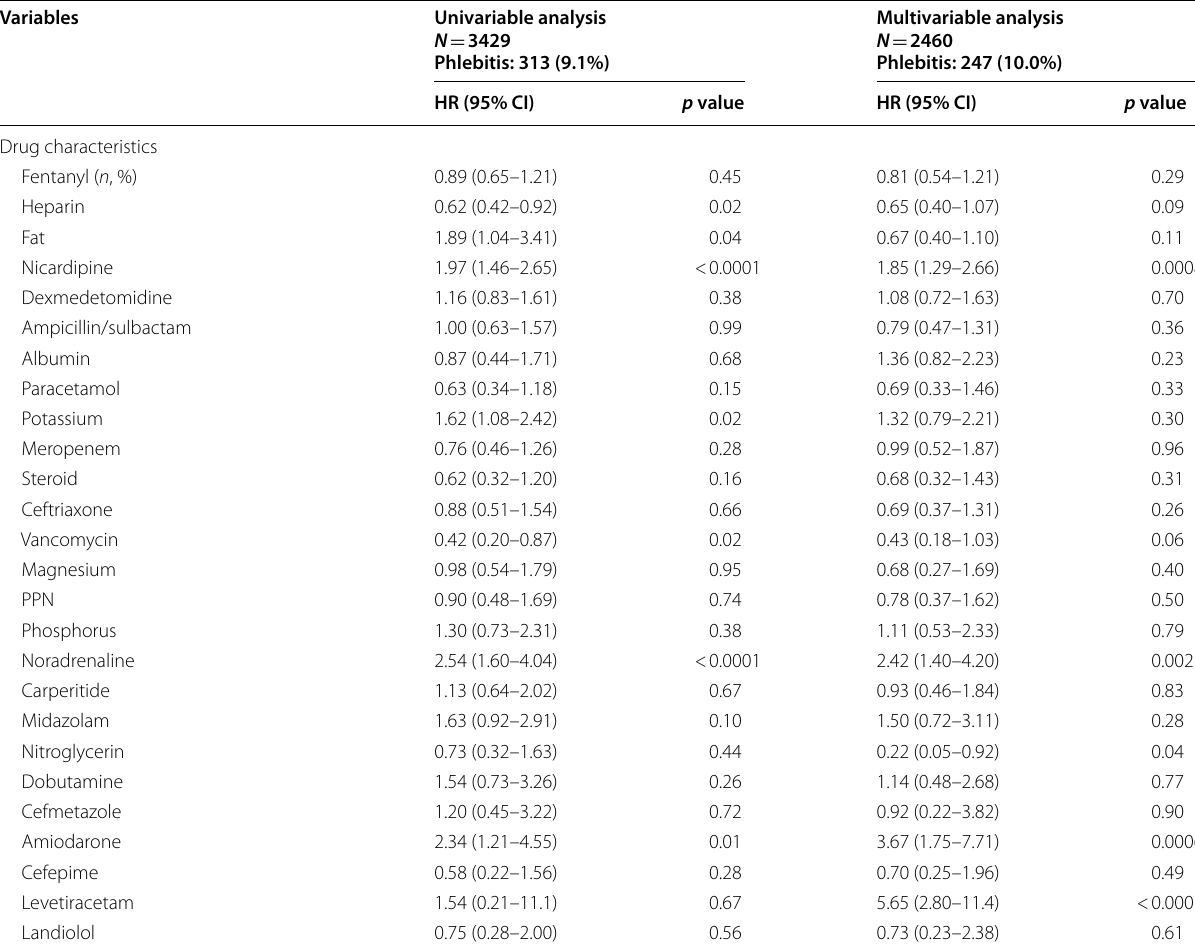
tional file 1: Table S5. The results were similar to those of the primary